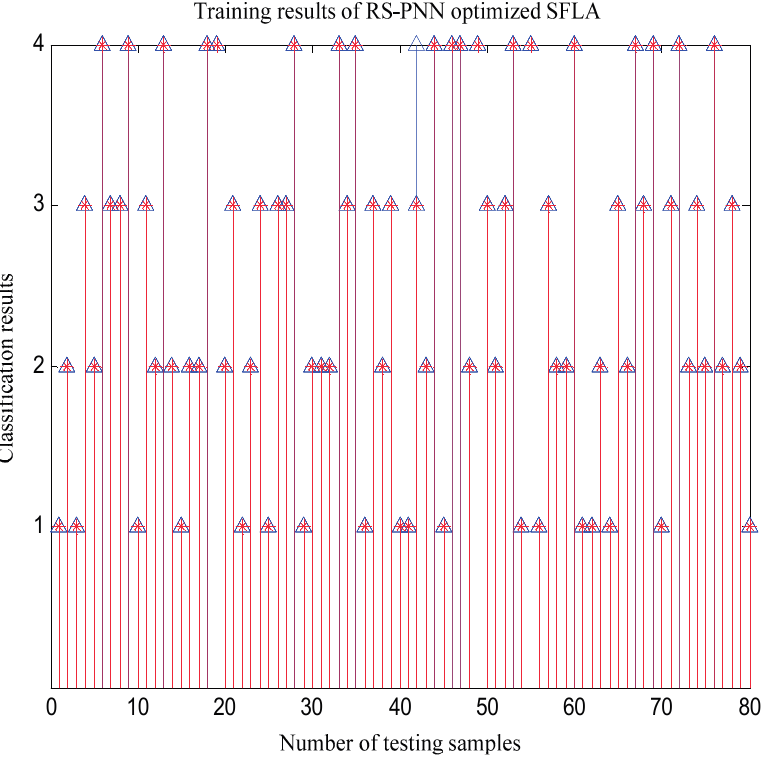
Figure 15. Classification results of RS-PNN optimized by SFLA under testing